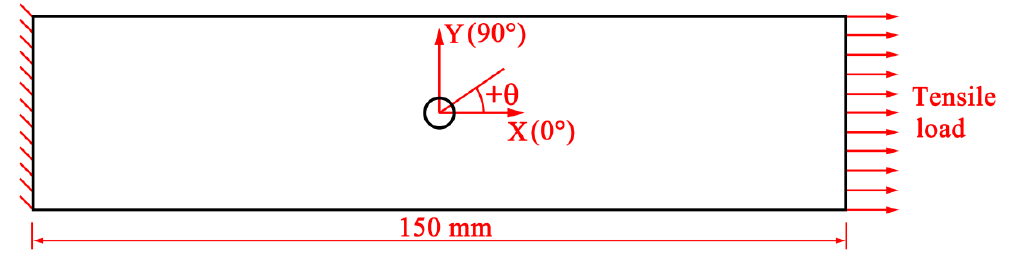
Figure 3. Schematic of the simplified calculation model with the fibre orientation